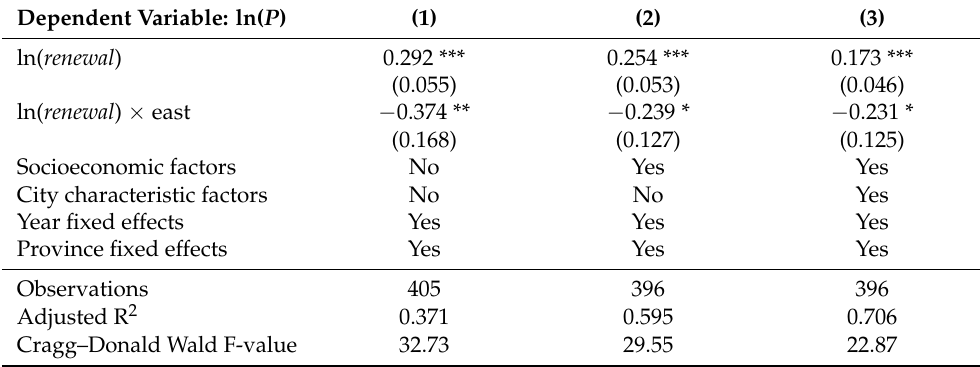
Table 5. Heterogenous effect: 2SLS estimation